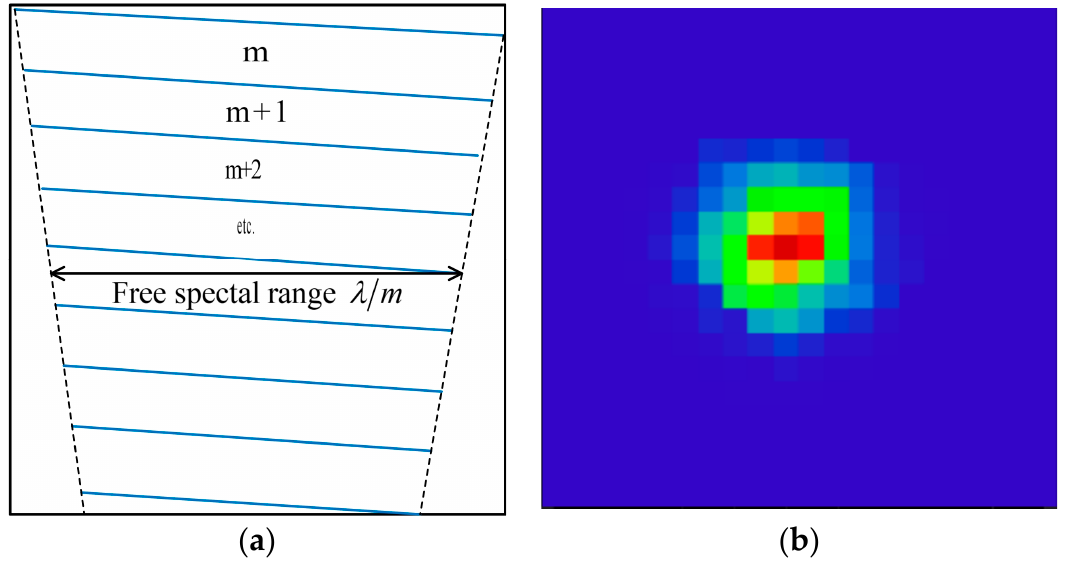
Figure 10. The echellogram in ( a ) shows the free spectral range of 36 orders on the detector of 320 × 256 pixels. The corresponding point spread function is plotted in ( b ).